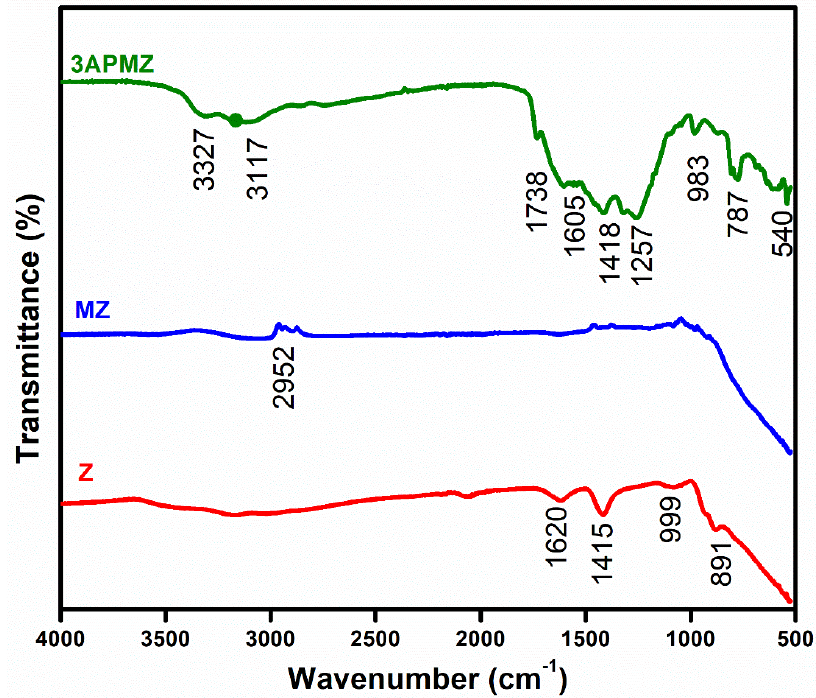
Figure 5. FTIR spectra of pure Z, MZ, and 3APMZ samples.